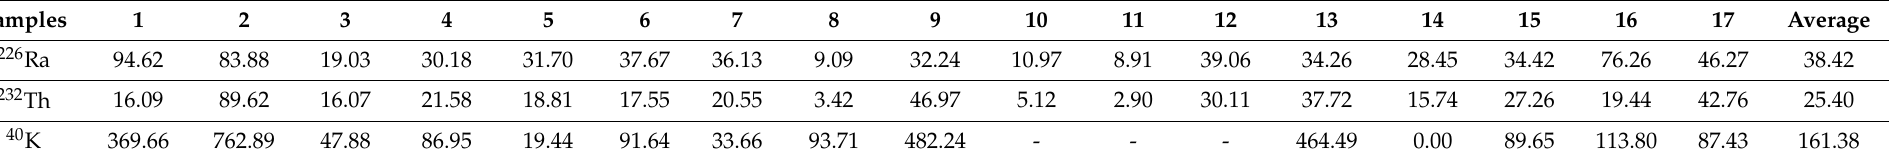
Table 3. Specific activity concentrations of 226 Ra, 232 Th, and 40 K in the 17 mining samples (Bq/kg).